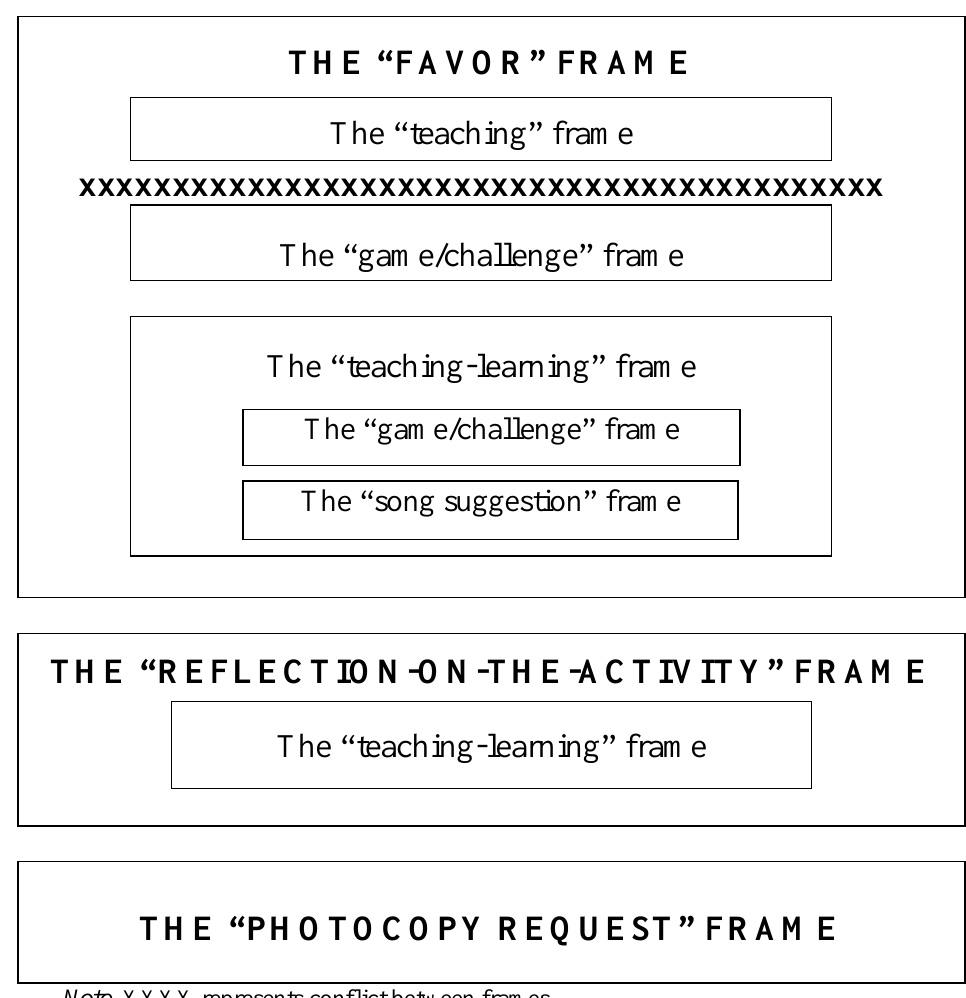
Schematization of the continuing, embedded and conflicting